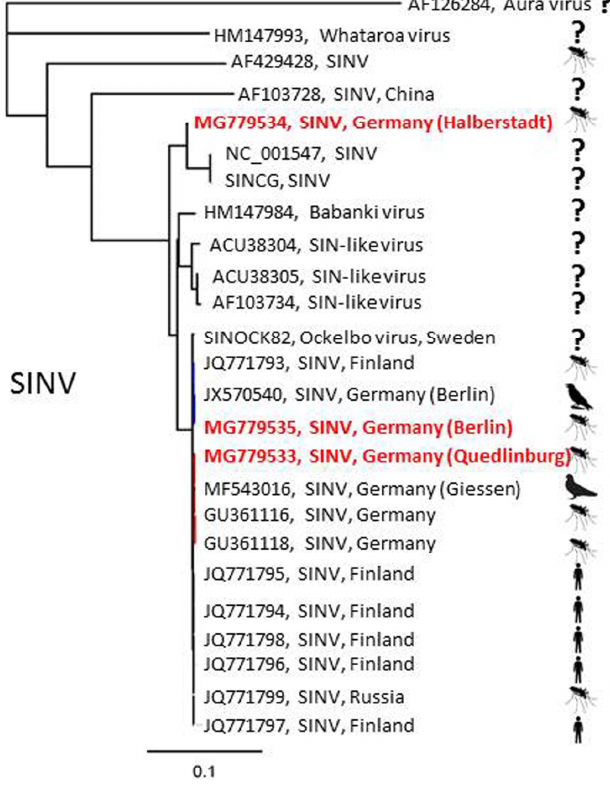
Figure 2. Phylogenetic tree based on full-genome sequences of SINV. Question mark = original source of the virus isolate is unknown to the authors. Red text marks samples of this